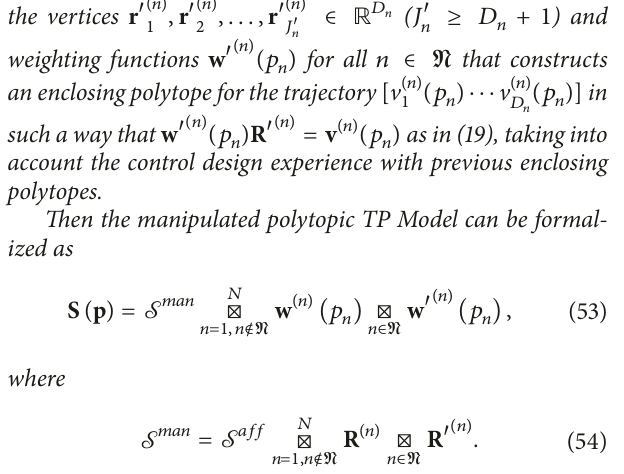
Figure 1: The mechanical model of the TORA